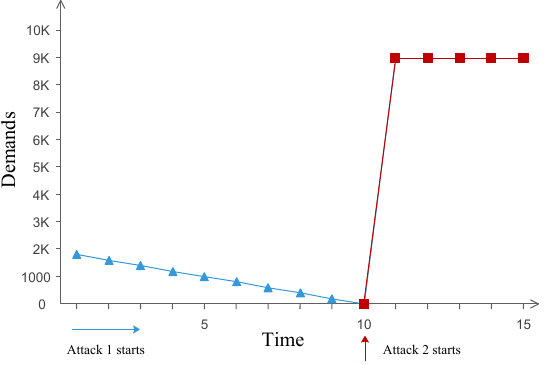
Figure 9. An example of the gradual reverse demands